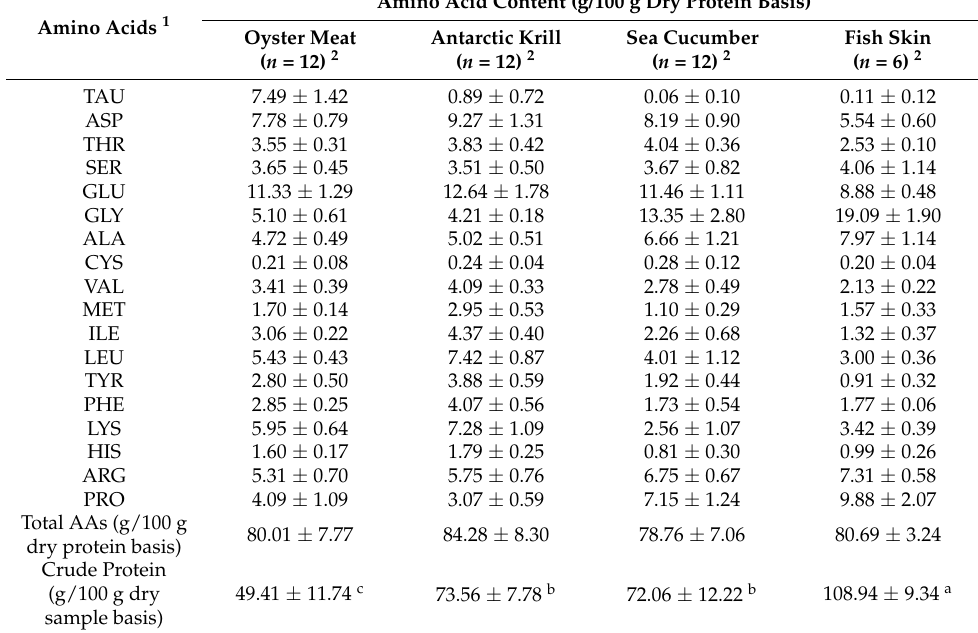
Table 1. Crude protein contents and hydrolyzed amino acid compositions of the four raw marine material